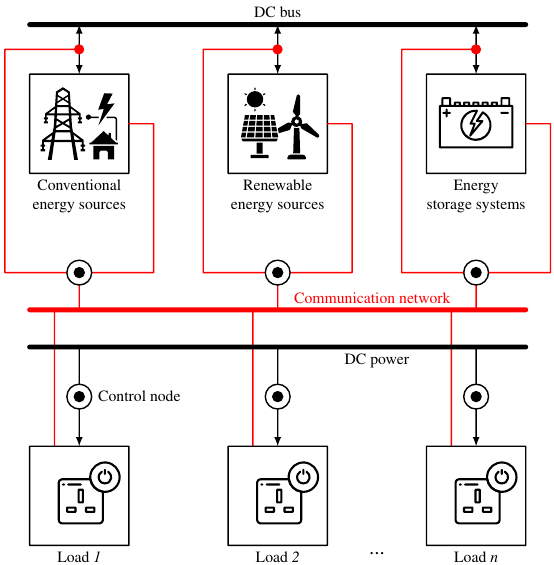
Figure 5. Distributed nanogrid